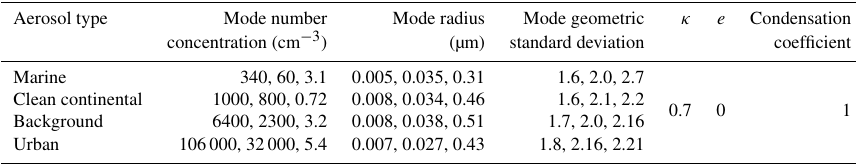
Table B1. Aerosol distribution and property parameters ( κ and e are aerosol hygroscopicity and entrainment rate, as mentioned in Appendix A and Sect. 2.1, respectively), referring to Whitby (1978) and Ghan et al. (2011).